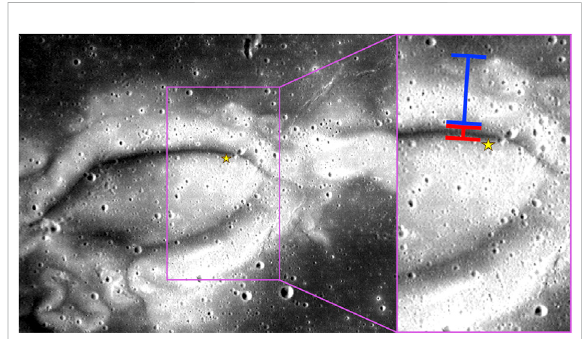
FIGURE 3 The heart of the lunar swirl named, Reiner Gamma, from the LROCWAC 100 m/pixel GlobalMorphologicbasemap(I/Fstretch: 0.017 – 0.037). The “ bright lanes ” are the regions of unusually high re fl ectance such as the region demarcated by the blue bracket, and the “ dark lanes ” are the regions of low re fl ectance similar to the mare background such as the region demarcated by the red bracket. The targeted LVx landing site (7.585 ° N, 58.725 ° W) is denoted by a yellow star, just below the highlighted dark